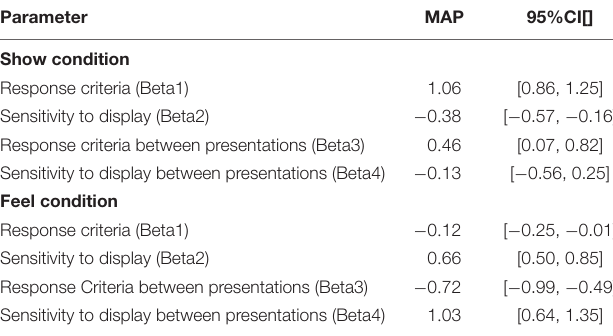
TABLE 2 | Estimated parameters on each condition for all emotions using a signal detection model.